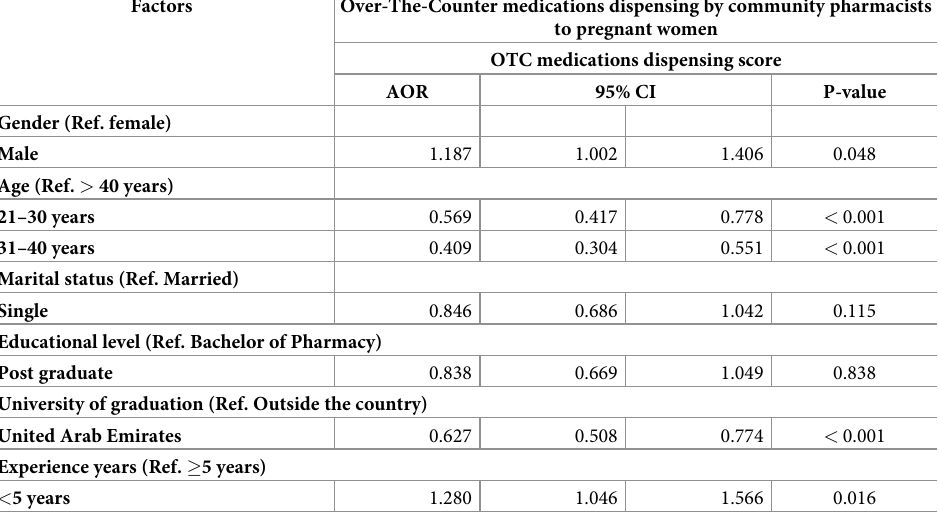
P-values less than 0.05 were considered statistically significant, Abbreviations : AOR, adjusted odds ratio; CI, confidence interval.